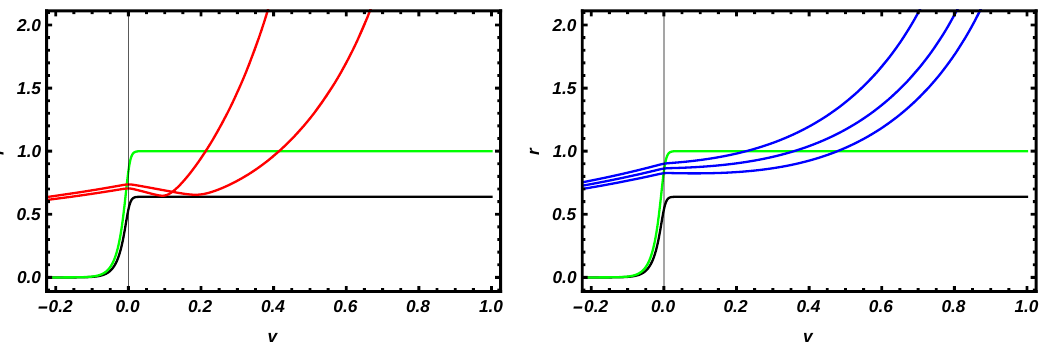
Figure 3 . Representative geodesics for negative (cid:21) GB and di(cid:11)erent boundary time. Left panel: the new family of solutions (red curves) that reach the singularity. Right panel: the standard solutions (blue curves) that asymptote to a critical surface and do not reach the singularity. In both panels the black curve is the singularity and the green curve is the apparent